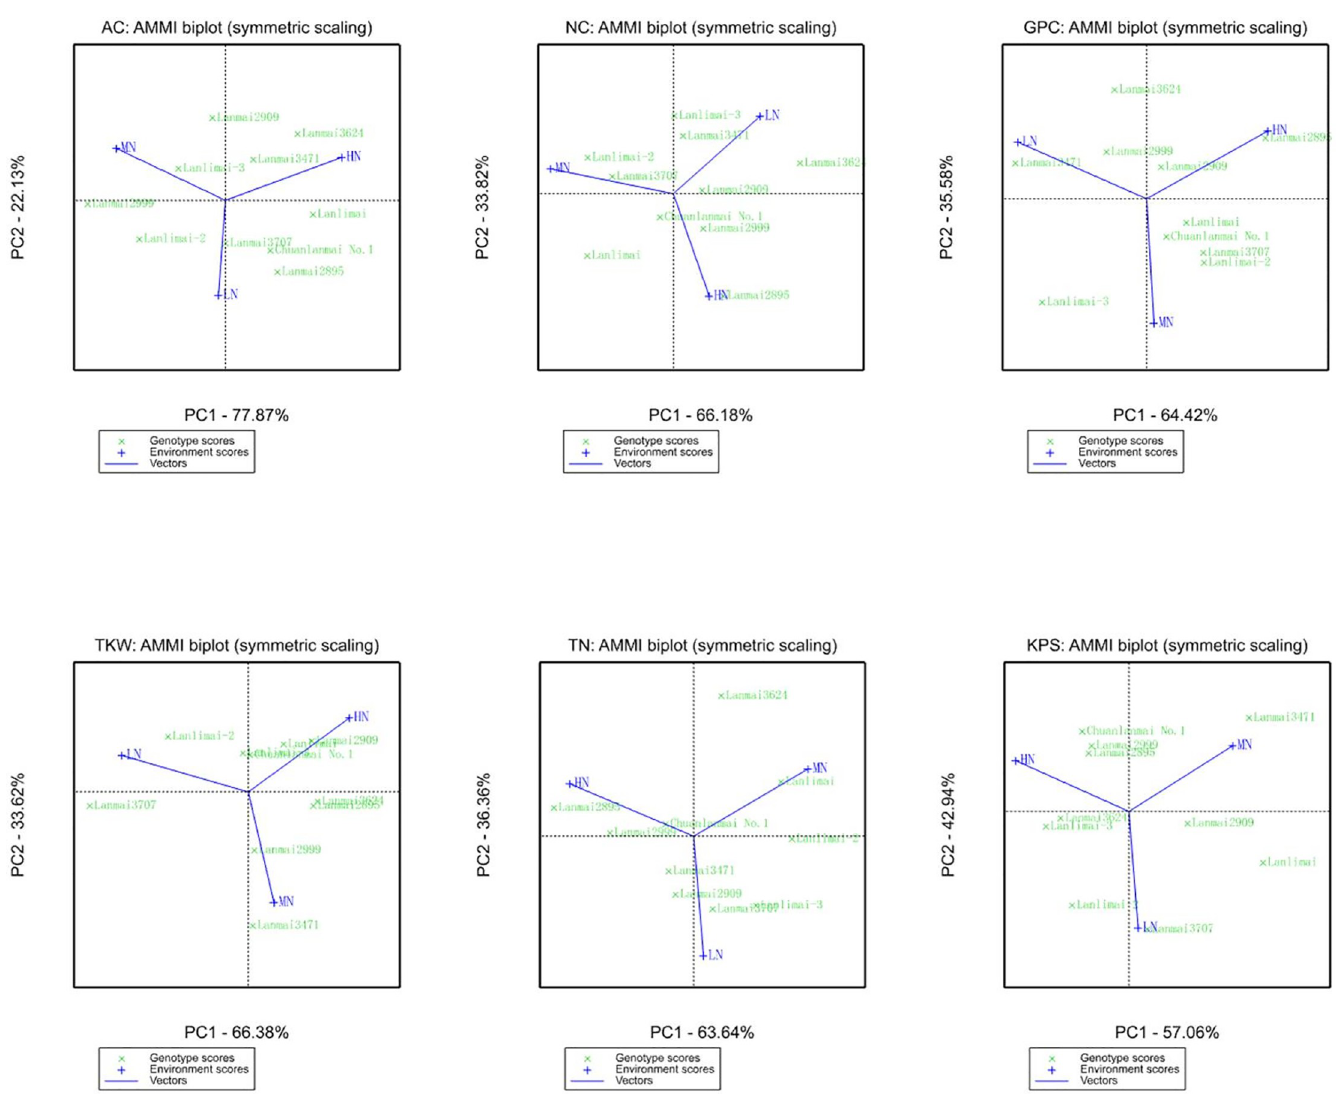
Fig 2. AMMI analysis of blue wheat lines for nutrient quality and yield composition